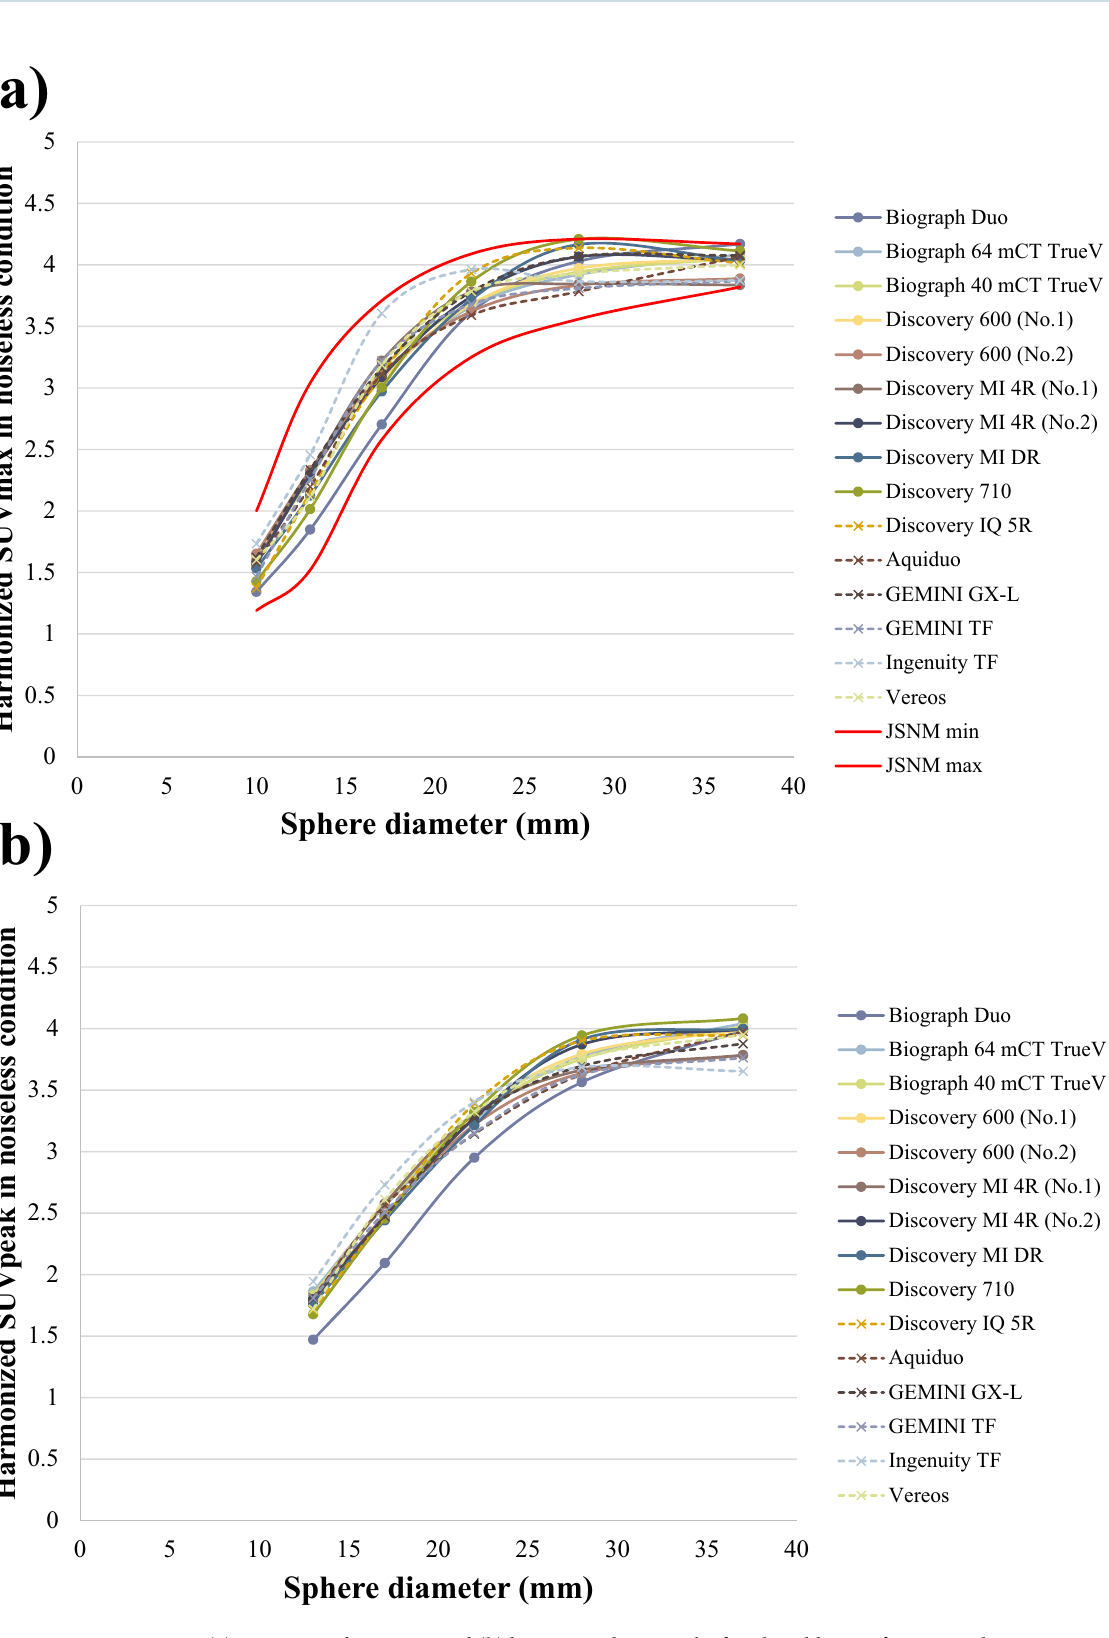
Figure 6. ( a ) Harmonized SUVmax and ( b ) harmonized SUVpeak after the addition of an optimal harmonization filter under noiseless conditions. The solid red lines show the upper and lower limits of the SUVmax defined according to the JSNM guidelines. The harmonized SUVmax were within the harmonization range of the JSNM guidelines for all the scanners. The actual values obtained using each scanner are shown in Online Resource 3 (harmonized SUVmax) and Online Resource 4 (harmonized